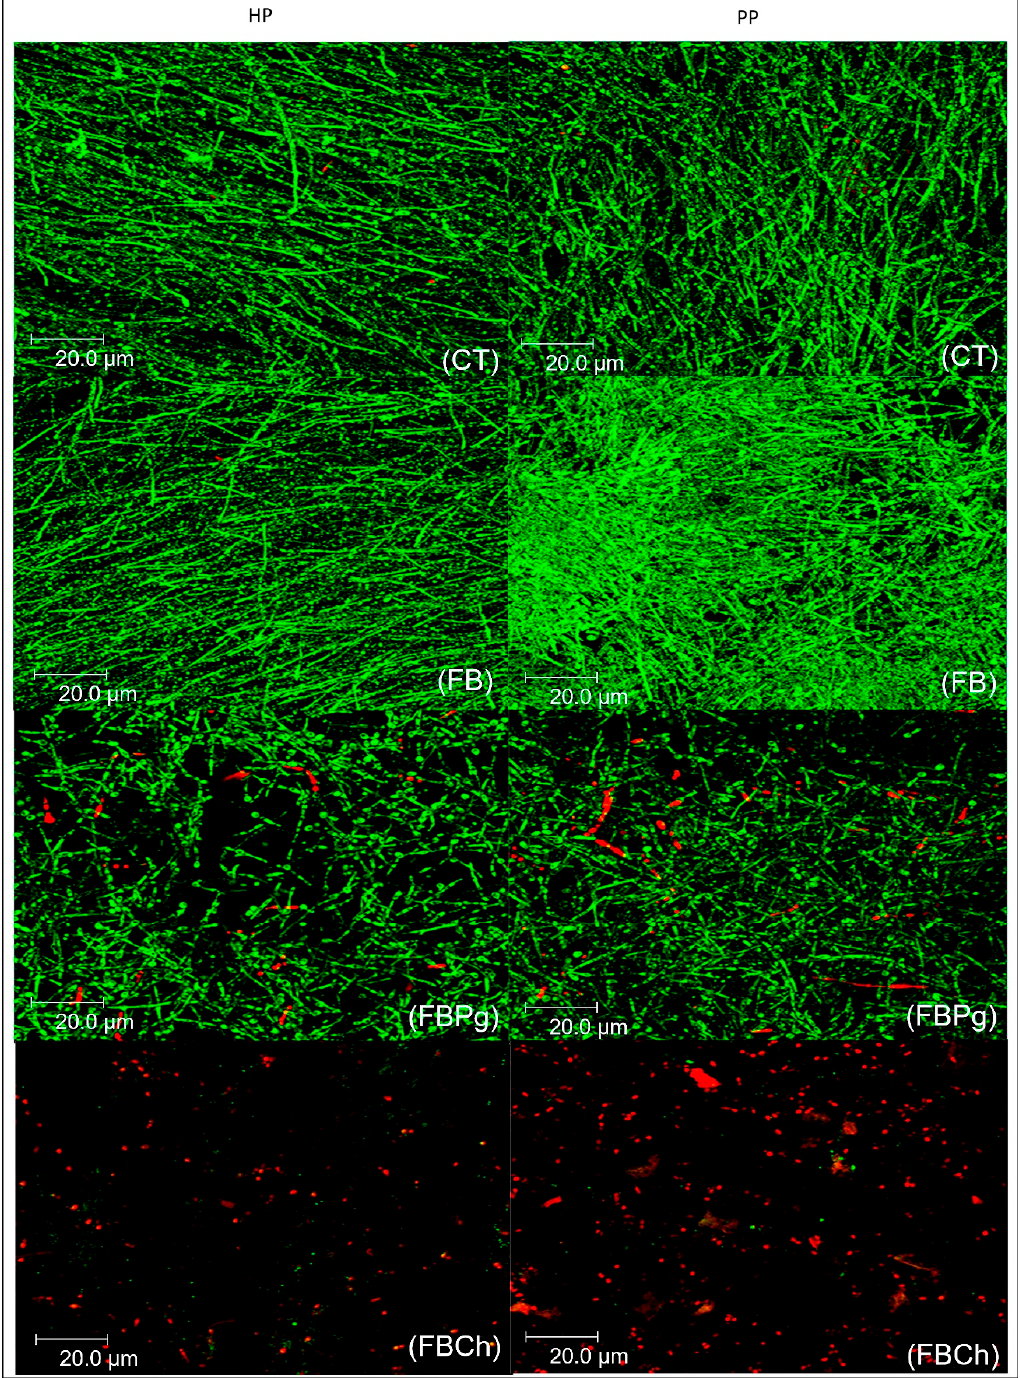
Figure 2. Confocal images of C. albicans biofilms developed on heat-polymerized (HP) and pre-polymerized (PP) surfaces after 48 h of incubation. CT: control; FB: Fibrin biopolymer; FBPg: P. granatum incorporated in fibrin biopolymer; FBCh: Chlorhexidine incorporated in fibrin biopolymer.